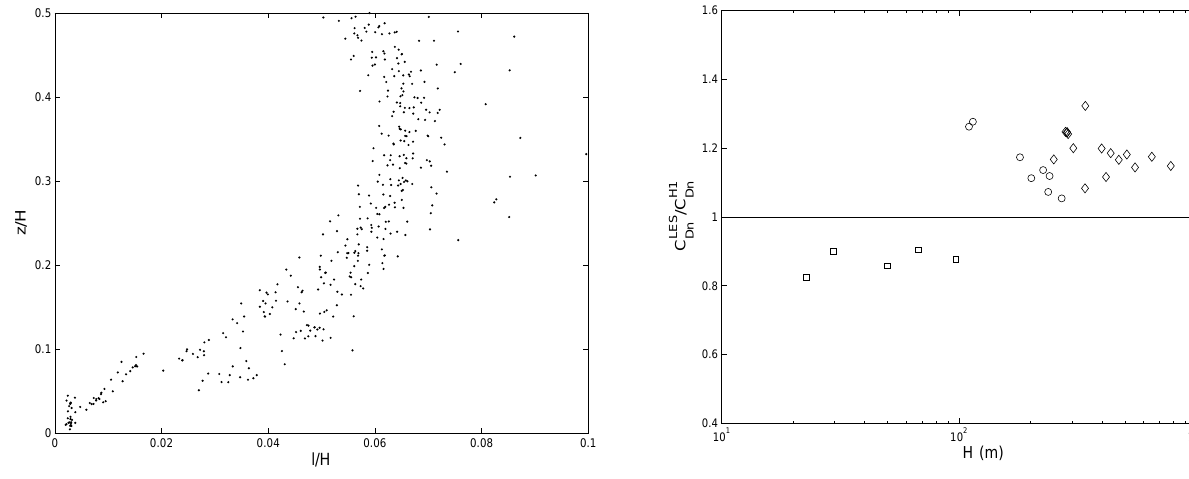
Fig. 6. The dependence of the non-dimensional mixing length scale, l/H , from the non-dimensional height, z/H . The mixing length scale is calculated as l = τ(z)/ ∇ z | u (z) | u − 1 ∗ from the author’s LES database.